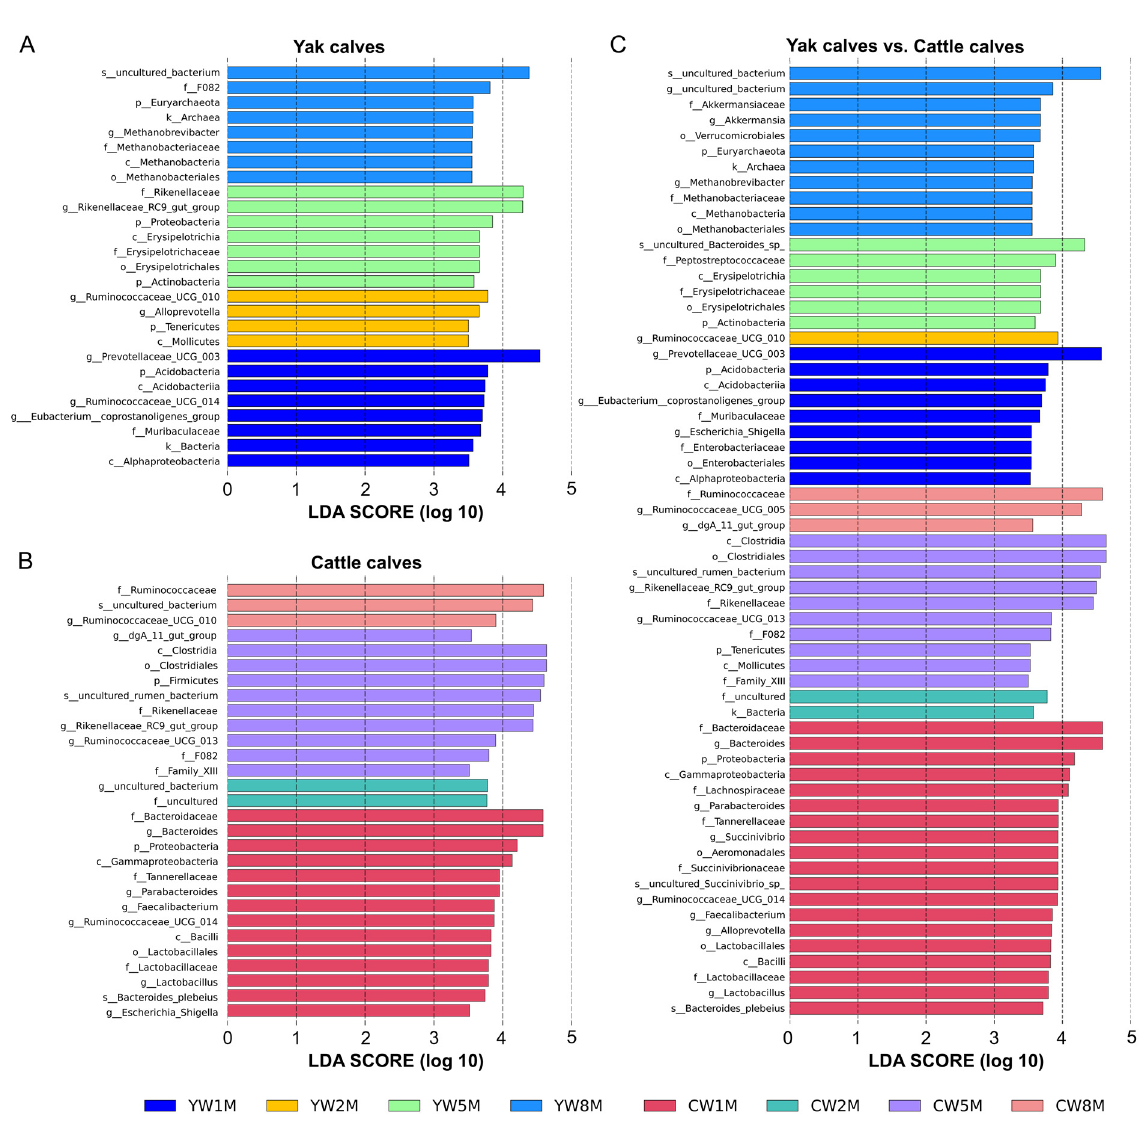
Figure 5. LEfSe analysis based on bacterial abundance data. LDA effect size (LDA score) comparison of fecal microbiota in yak calves ( A ), cattle calves ( B ), and between yak and cattle calves ( C ). The LDA cut-off score is 3.5. Letters in front of ASVs represent taxonomic levels (p, phylum; c, class; o, order; f, family; g, genus; s, species). The bar chart shows the different species in the fecal microbiota of calves in different months after weaning. Different colors represent different months after